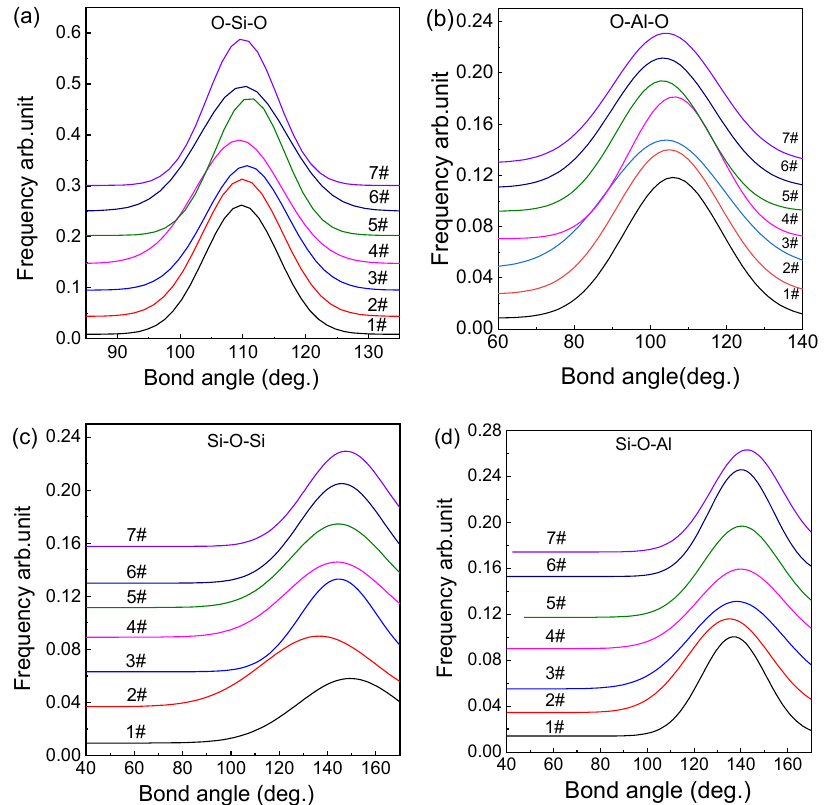
Figure 4. Distribution of bond angles of ( a ) O–Si–O, ( b ) O–Al–O, ( c ) Al–O–Al, and ( d ) Al–O–Si.